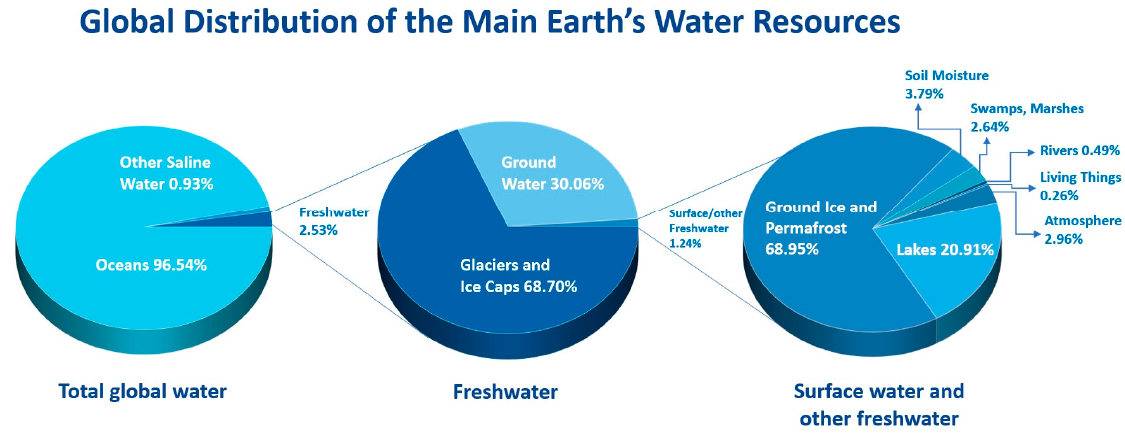
Figure 1. Distribution of Earth’s water resources.